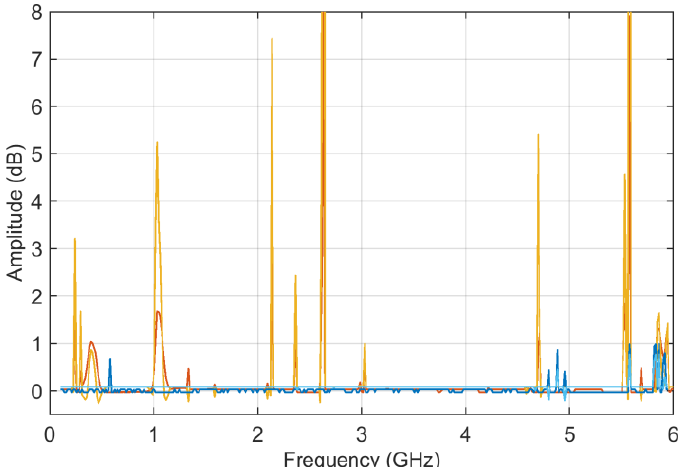
Figure 14. S 11 input data in logarithmic scale: skewness in dark color and kurtosis (offset around 0) in light color for ADM i (orange sk and yellow ku ) and FDM i (blue sk and light blue ku ).